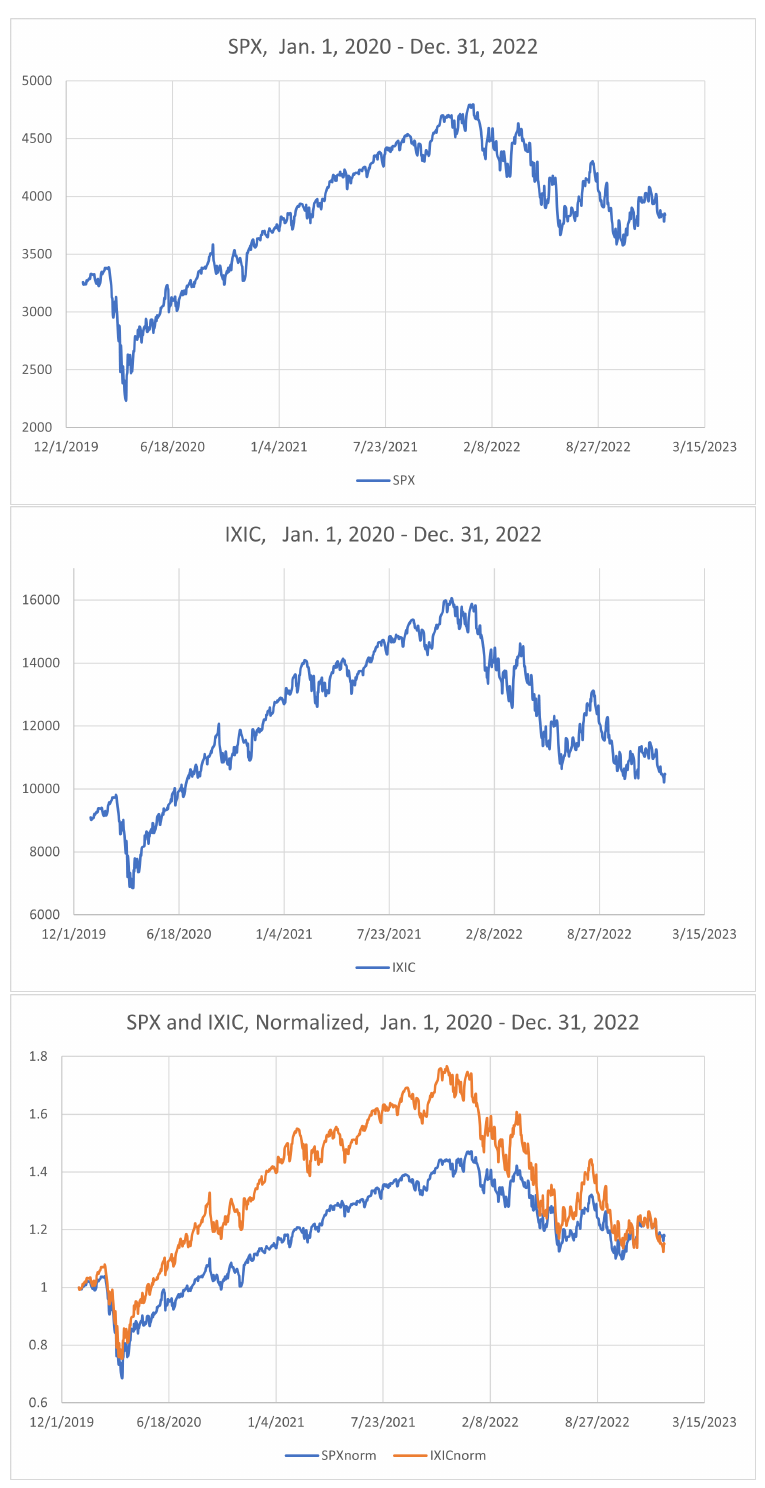
Figure 4. The performance of SPX over the period 2020–2022 ( top ), IXIC ( middle ), and normalized indices ( bottom ) which facilitates comparisons. It is obvious from the normalized index figure ( bottom ) that SPX and IXIC are highly correlated, but that IXIC moves more (in technical jargon, it has a higher beta). It is interesting to note that for the full 3-year period 2020–2022, both indices actually ended up positive: SPX was up 17.9%, while IXIC was up 15.1%, which are certainly not bad returns for the simple BnH method over such a volatile period. However, the maximum drawdowns during the period were certainly distressing (33.9% for SPX, and 35.9% for IXIC). Can we do